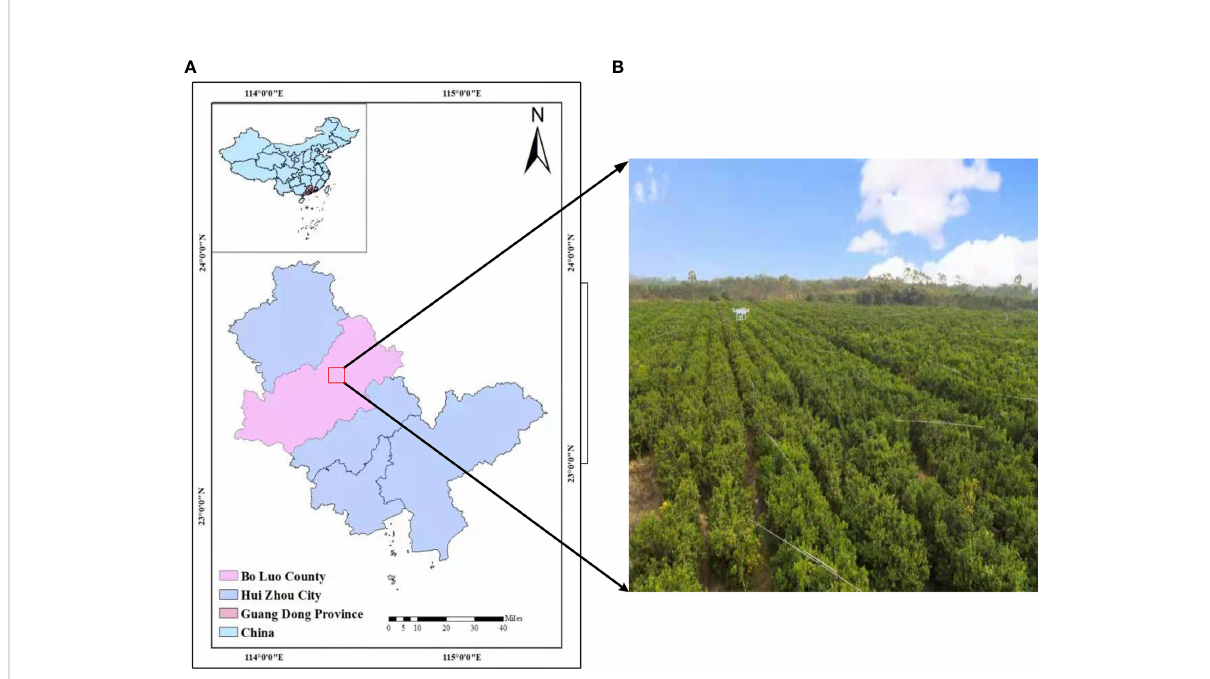
FIGURE 1 Study Area: (A) Geographical location of the study area and (B) the citrus test